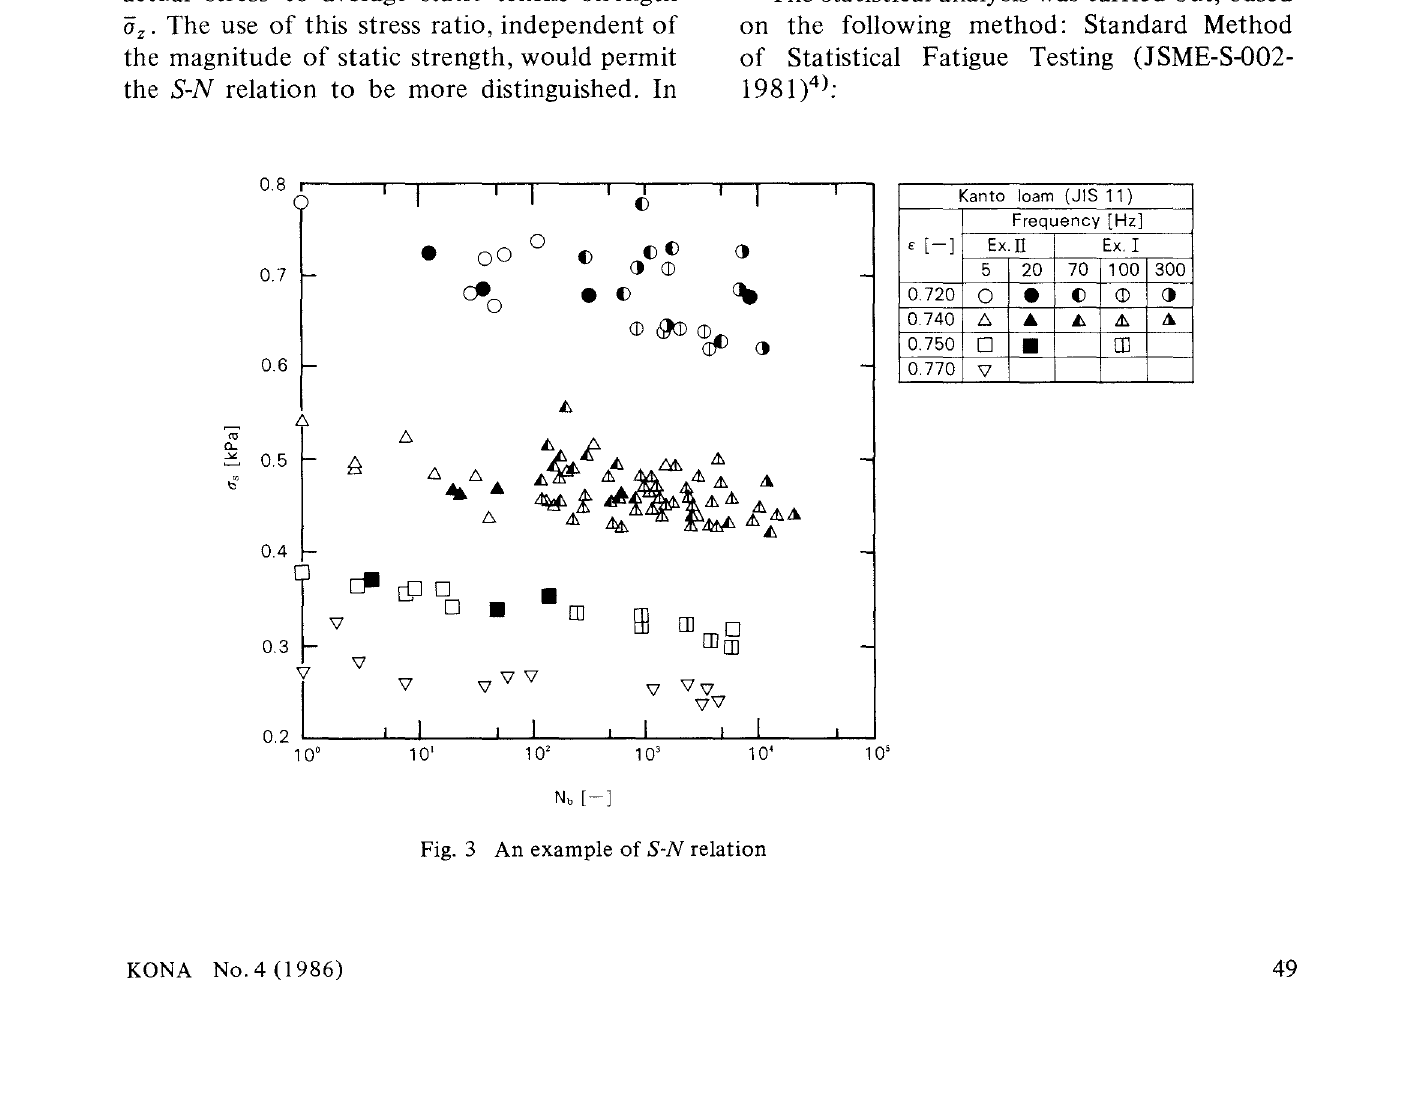
Fig. 3 An example of S-N